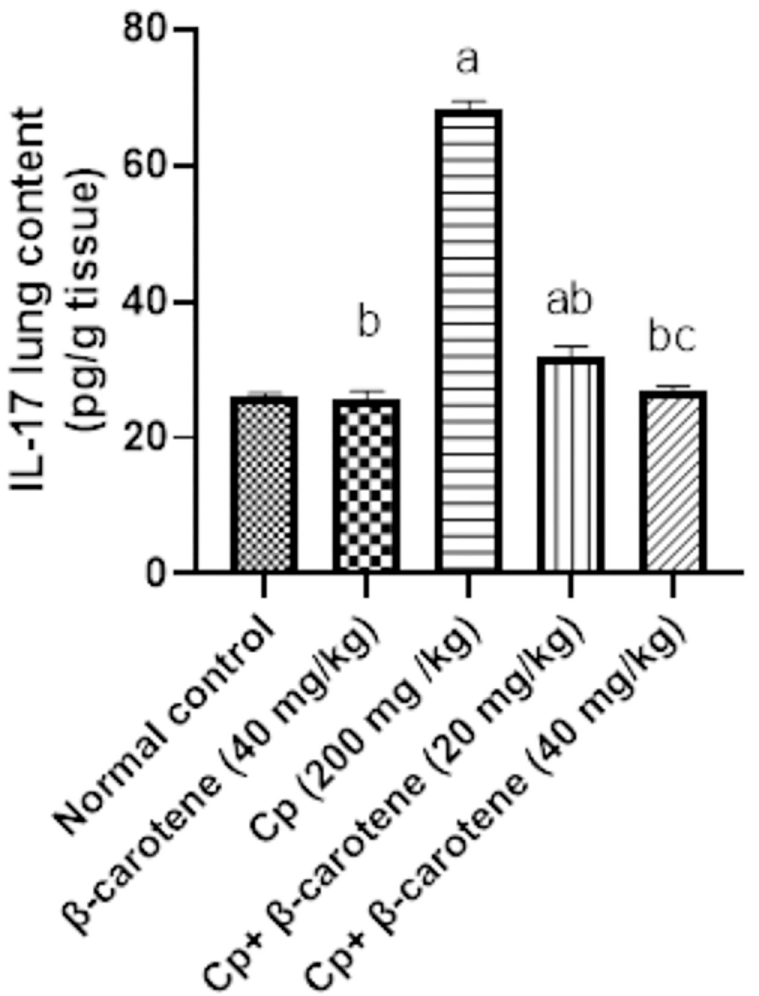
Fig 8. Effect of β -carotene on the IL-17 lung content. a Significantly different from the control group. b Significantly different from the CP group. c Significantly different from the CP + β -carotene 20 mg/kg group at P < 0 . 05 .